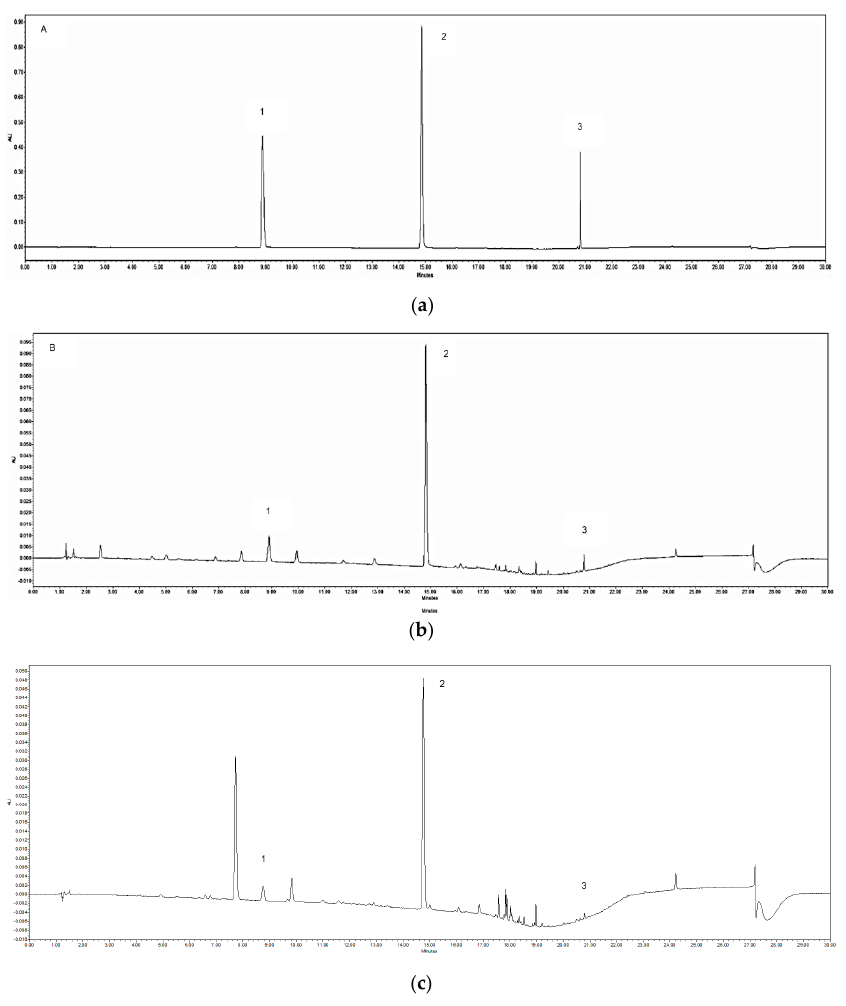
Figure 1. UPLC chromatograms detected under the developed mobile phase system at 325 nm. These chromatograms show: ( a ) three marker compounds: 1 = caffeic acid (0.1 mg/mL), 2 = ferulic acid (0.2 mg/mL), 3 = Z-ligustilide (0.1 mg/mL); ( b ) granule 1 (G1) sample (10 mg/mL); ( c ) raw herb 2 (R2) sample (10 mg/mL). AU = absorbance units. Table 1. Average contents (mg/g, means ± SD, n = 3) of the chemical markers in the ten Danggui granule samples (G1–G10) and the five herb/decoction piece samples (R1–R5) analysed by UPLC- PDA.